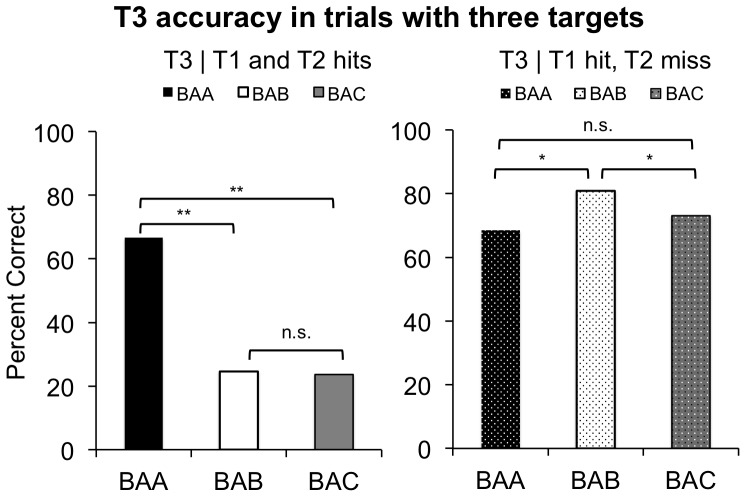
T3 accuracy in trials with three targets.The left panel shows T3 accuracy in BAA, BAB, and BAC trials given that both T1 and T2 were identified. Consistent with set-specific capture, T3 accuracy was lower when T2 and T3 matched different attentional sets (BAB and BAC trials) than when they matched the same attentional set (BAA trials). Critically, in line with the FOA model, T3 accuracy did not vary with whether T1 and T3 matched the same attentional set: T3 accuracy in BAB and BAC trials did not significantly differ. The right panel shows T3 accuracy given that T1 was identified and T2 was missed. In line with the FOA model, in these trials T1’s attentional set did influence T3 accuracy, while T2’s set did not. That is, T3 accuracy was higher in BAB trials than in either BAA or BAC trials, but did not differ between BAA and BAC trials. A double asterisk indicates p<0.0005, and a single asterisk indicates p<0.05.